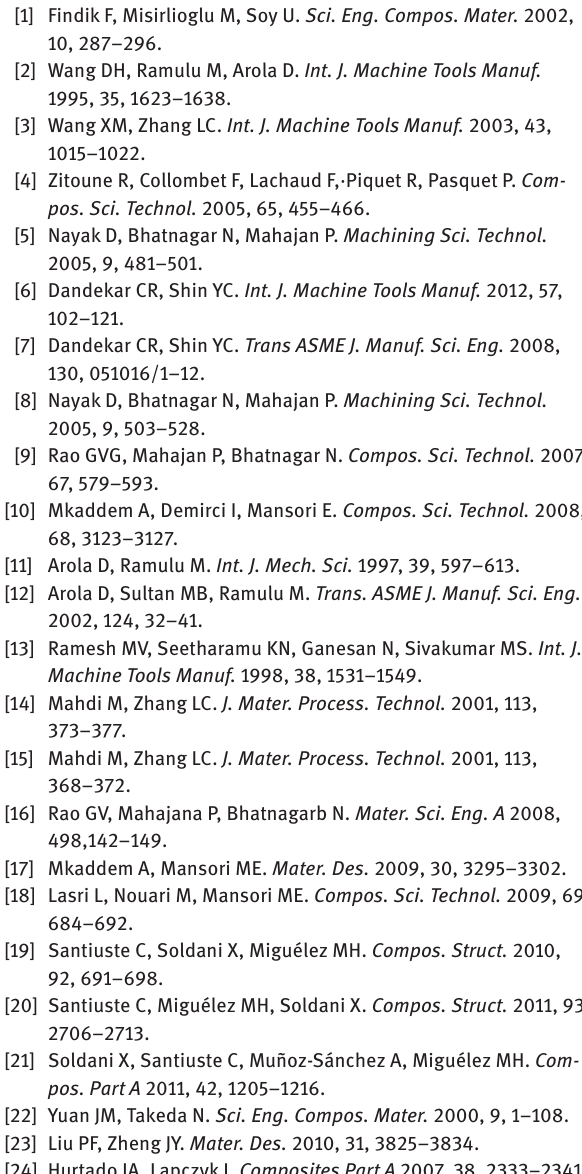
Figure 10: Sub-surface damage versus fiber